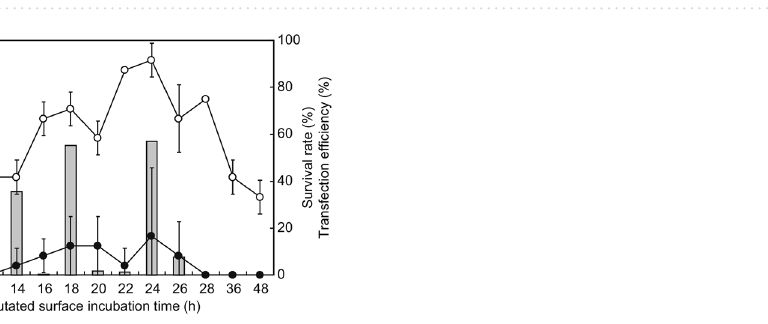
Figure 2. Effect of amputated tail surface incubation time on survival rate and transfection efficiency of E. fetida . The electroporation conditions were 35 V and 3 pulses/s at 1 s intervals for 60 ms. All experiments were performed using three groups of eight randomly selected mature earthworms. Open circles, survival rate; closed circles, transfection efficiency; bar graphs, maximum luminescence intensity; cps, counts per